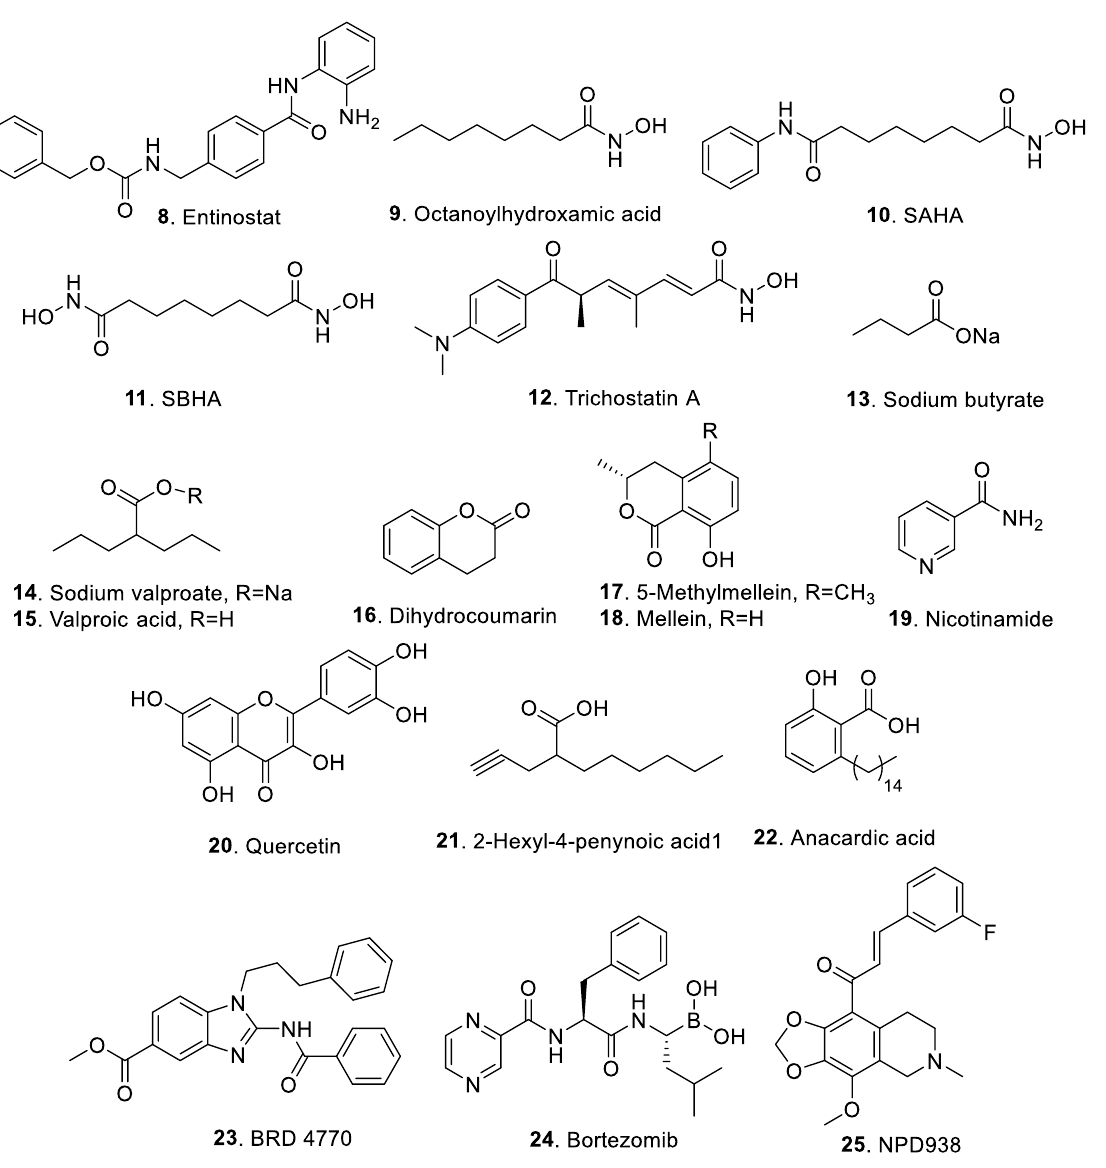
Figure 1. Structures of the epigenetic small organic chemicals 1 – 25 that affect secondary metabolism in